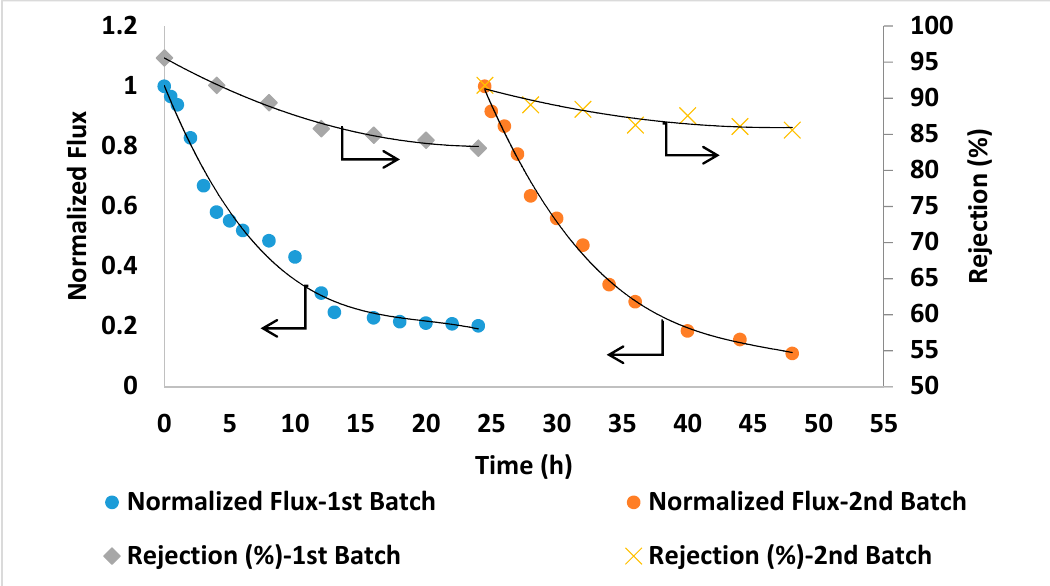
Figure 13. Flux and salt rejection vs time of the commercial membrane (Dow SW30HR). TDS of the feed solution: 45,000 ppm, pH 8.36. Operating pressure: 54 bars.